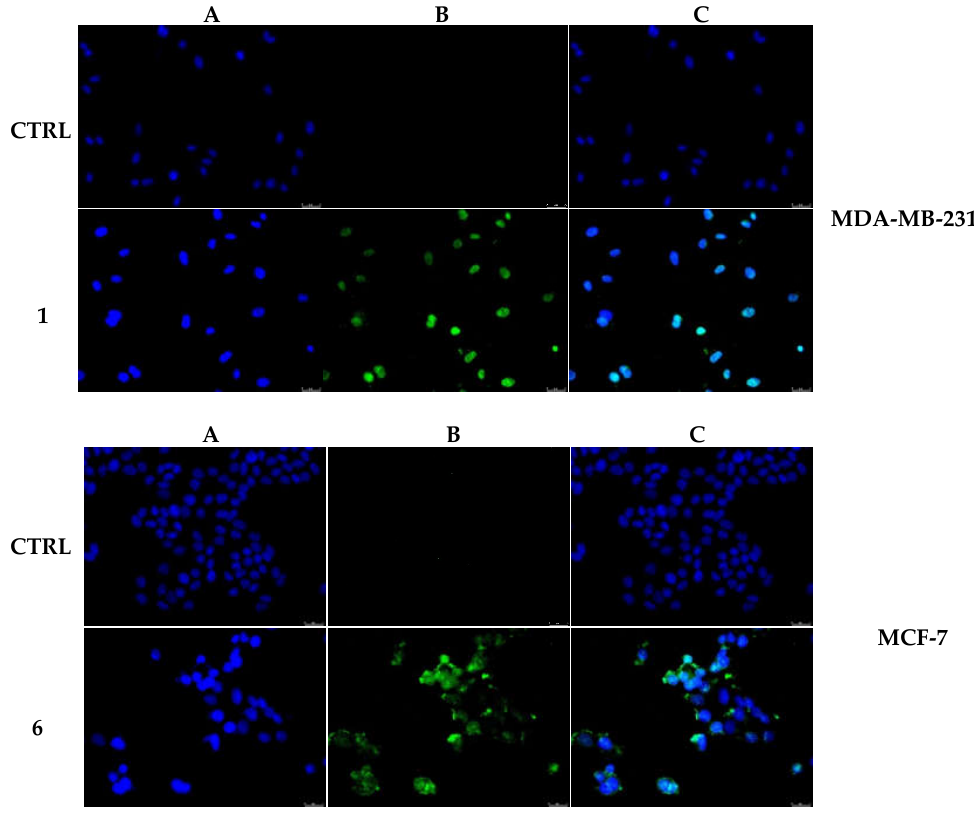
Figure 9. TUNEL assay. MDA-MB-231 and MCF-7 breast cancer cells were treated with com- pounds 1 and 6 , respectively, at the concentration equal to their IC 50 or with vehicle (CTRL) for 24 h. Then they were exposed to the TdT enzyme and visualized under a fluorescence microscope (20 × magnification). The green fluorescence indicates nuclei of cells undergoing apoptosis. Panels ( A ), DAPI λ ex/em 350 nm/460 nm. Panels ( B ), CF TM 488 A λ ex/em 490 nm/515 nm. Panels C show the overlay